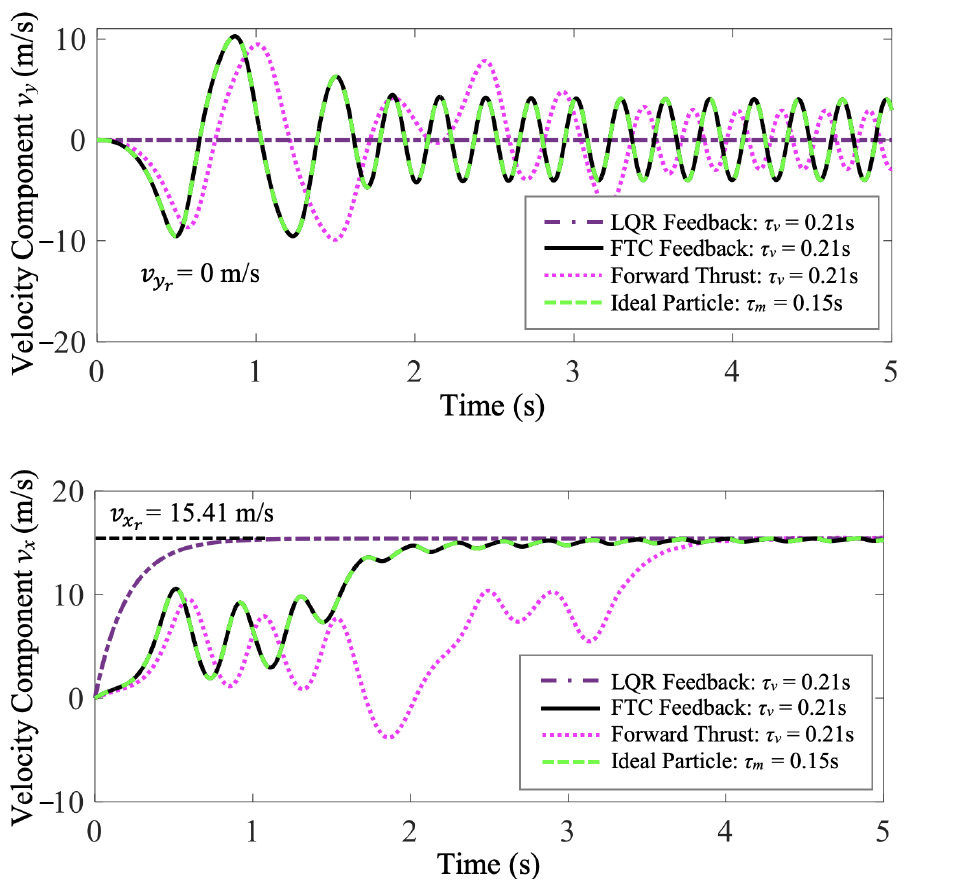
Figure 4. Case study 1: the comparison of the velocity time histories of FTC-controlled and LQR- controlled vehicles shows that they both achieve and maintain the desired steady-state velocities ( v x and v y r